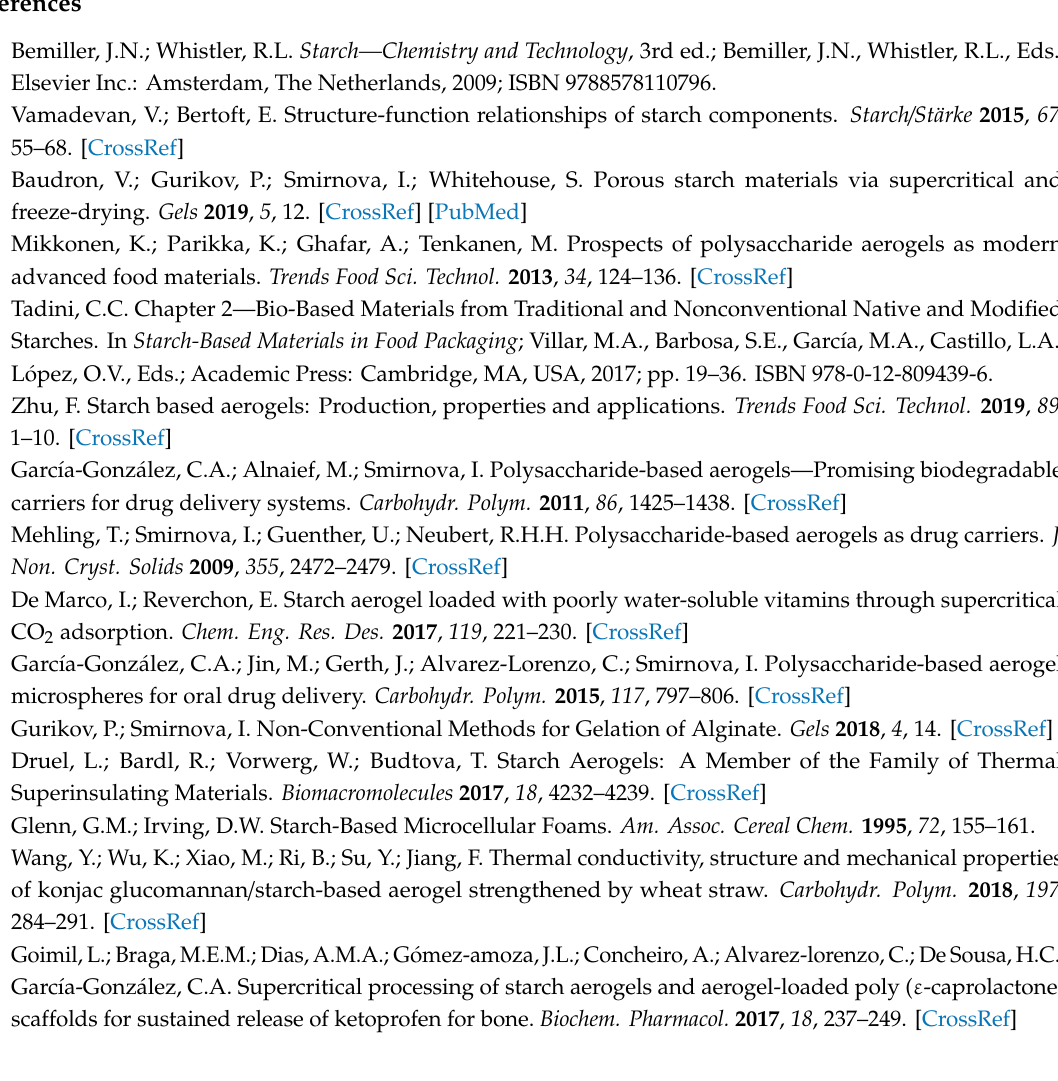
Figure S1: G’ and G” profile of gel samples containing 5% of starch and di ff erent water-to-DMSO proportions: (a) 20:80, 30:70, and 50:50; (b) 70:30 and 80:20; Figure S2: G’ and G” profile of gel samples containing 7.5% of starch and di ff erent water-to-DMSO proportions: (a) 20:80, 30:70, and 50:50; (b) 70:30 and 80:20; Figure S3: G’ and G” profile of gel samples containing 15% of starch and di ff erent water-to-DMSO proportions: (a) 20:80, 30:70, and 50:50; (b) 70:30 and 80:20. Table S1: Visual appearance of the samples prepared with di ff erent starch concentrations, type of solvent, and solvent-to-DMSO mass ratios; Table S2: Calculated solubility parameters of mixture ( δ m ) for di ff erent solvent / DMSO mixtures and visual appearance of samples; Supporting information: Volume fraction calculation for the solvent / DMSO mixtures. References [34] is cited in the supplementary